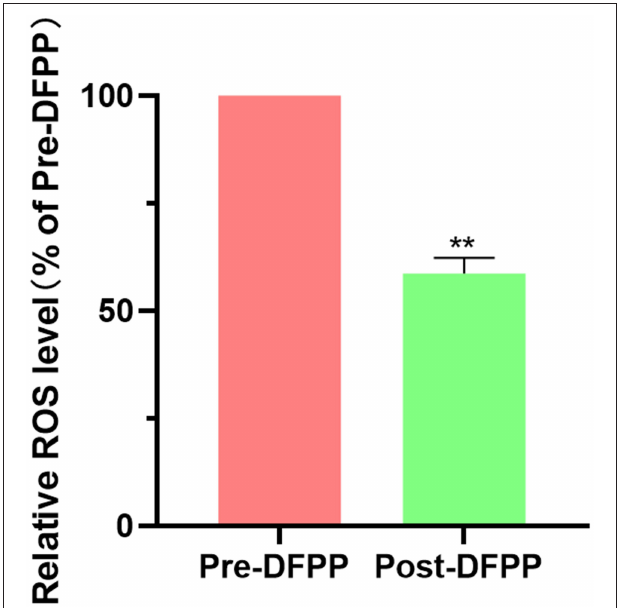
FIGURE 4 | DFPP reduces ROS level. PBMCs samples are extracted from patients with high cholesterol and/or high LDL-C. PBMCs. ROS levels were measured by flow cytometry before and after DFPP treatment. PBMCs were suspended in the diluted fluorescent probes and incubated in a plate at 37 ◦ C for 20min. The result was expressed as a percentage of pre-DFPP. Values were expressed as mean ± SD. ** P < 0.01 vs. pre-DFPP. N = 5.